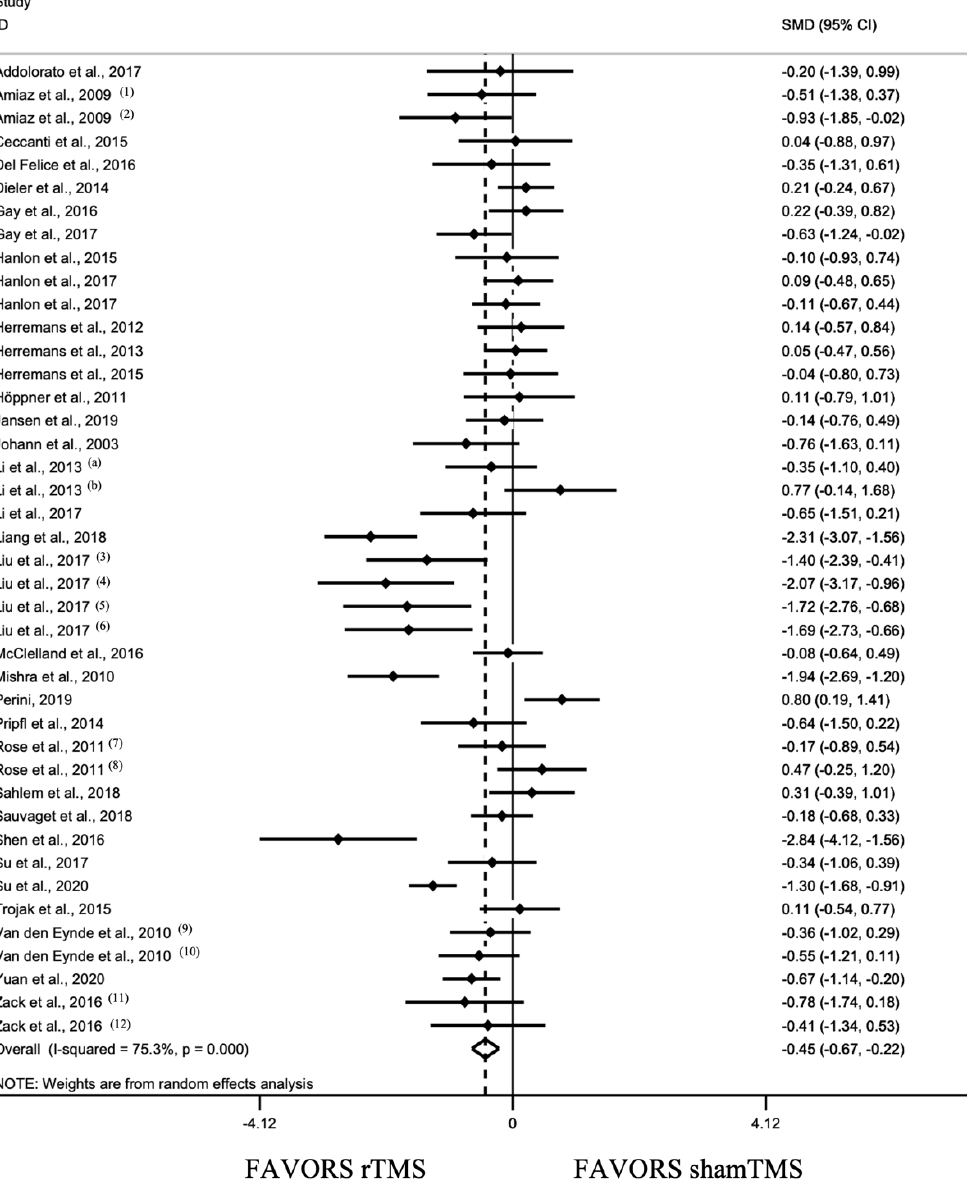
Figure 3. Forest plot for all included studies pooled together using random effects model (34 studies, 42 units of analysis) [80–113]. Heterogeneity: Q = 165.67, df = 41, p < 0.001, I 2 = 75.3%. (1), craving evaluated by Visual Analog Scale (VAS); (2), craving evaluated by sTCQ; (3), high frequency left DLPFC stimulation; (4), high frequency right DLPFC stimulation; (5), low frequency left DLPFC stimulation; (6), low frequency right DLPFC stimulation; (7), low frequency stimulation; (8), high frequency stimulation; (9), craving evaluated by VAS; (10), craving evaluated by FCQ-s; (11), high frequency MPFC stimulation; (12), low frequency right DLPFC stimulation; (a), [103]; (b), [89]. Based on visual inspection of a funnel plot (Figure 4), we excluded 12 units of analysis and performed sensitivity analyses on the remaining units of analysis ( k = 30). The test for heterogeneity was no longer significant ( I 2 = 0%). This analysis revealed a pooled stand- ardized effect size of g = −0.228 (95% CI: −0.355, −0.102), indicating an overall small effect size favoring active stimulation over shamTMS stimulation ( z = 3.53, p < 0.001).